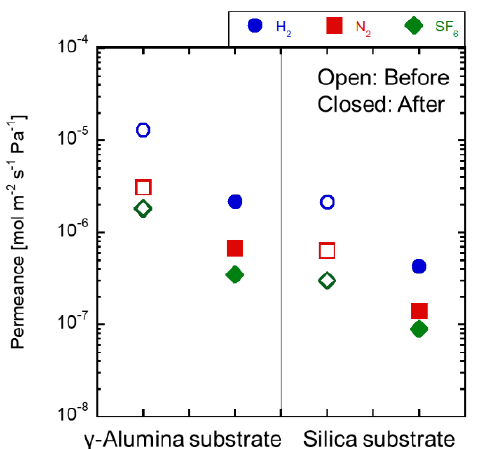
Figure 9. Gas permeance change of each substrate before and after CVD (Precursor: DPhDMOS, Deposition period: 90 min).